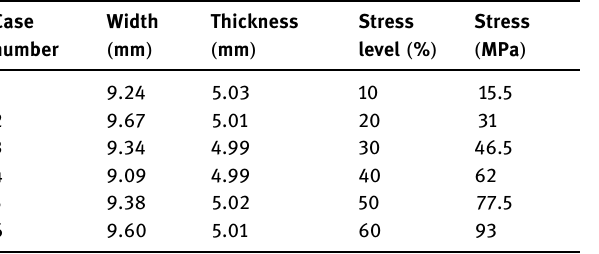
Table 3: Load parameters of the creep experiment Case